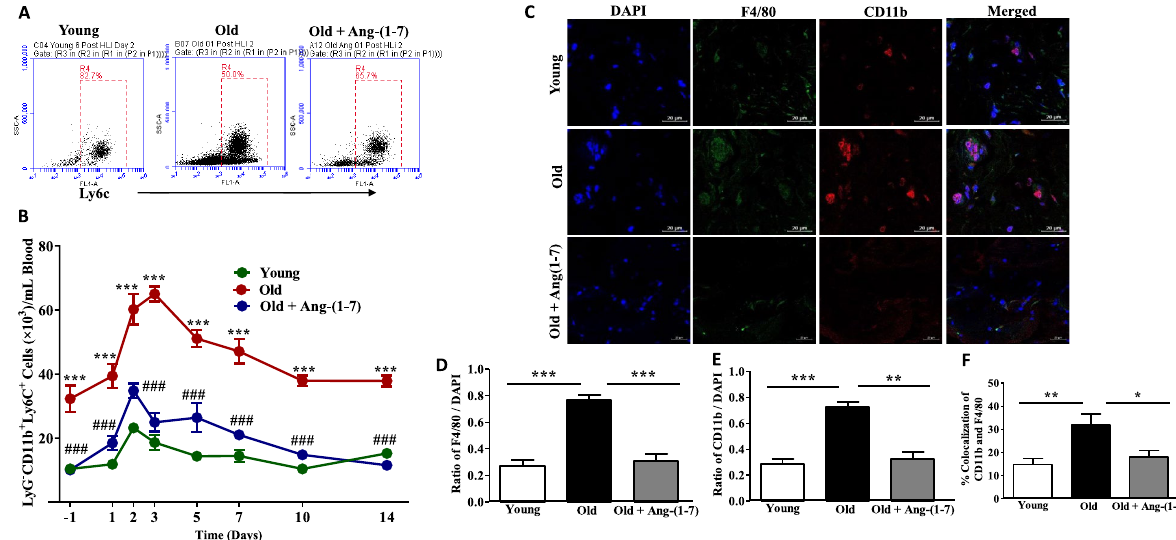
Figure 3. Mobilization and recruitment of monocyte-macrophages to areas of ischemia are higher in aging mice—Reversal by Ang-(1–7): ( A ) Shown were representative dot plots of monocytes (Ly6G - CD11b + Ly6C + cells) from Young, Old and Ang-(1–7)-treated Old mice on Day-2 post-ischemic injury. ( B ) Time-course of mobilization of monocytes into the blood stream in three different experimental groups. Two-way ANOVA detected significant differences in the time course or mobilization in three groups (P < 0.0001, n = 6). Bonferrroni’s post-test for multiple comparisons identified monocyte levels in the circulation are higher in the Old group compared to Young at all time points ( *** P < 0.001, n = 6) and Ang-(1–7) treatment decreased the mobilization of monocytes in the Old group at all time points tested ( ### P < 0.001, n = 6). ( C ) Shown were representative immunofluorescence images of gastrocnemius muscle sections from ischemic limbs derived from three experimental groups stained for DAPI, F4/80 and CD11b for identifying monocytes (CD11b) and macrophages (F4/80). Scale bar measures 20 microns. ( D , E ) Quantification of CD11b and F4/80 fluorescence, respectively, in ischemic muscle sections from three different experimental groups. One-way ANOVA detected significant increase in macrophages (P < 0.001, n = 5) and monocytes (P < 0.001, n = 5) compared to the Young in the Old group, which was decreased by Ang-(1–7) (P < 0.001 and P < 0.01, respectively, n = 5) (two sections from each